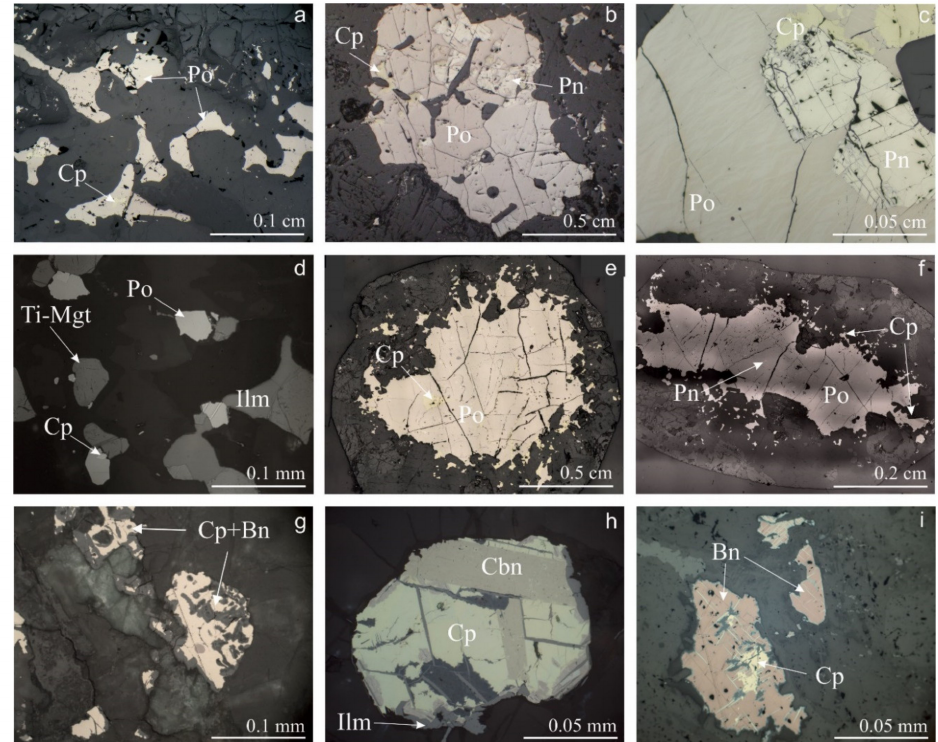
Figure 5. Microphotographs in reflected light of sulfides mineralization in the mafic-ultramafic massifs of the Khangai upland. ( a – c ) Ortsog massif: ( a ) interstitial sulfides; ( b ) sulfide droplet